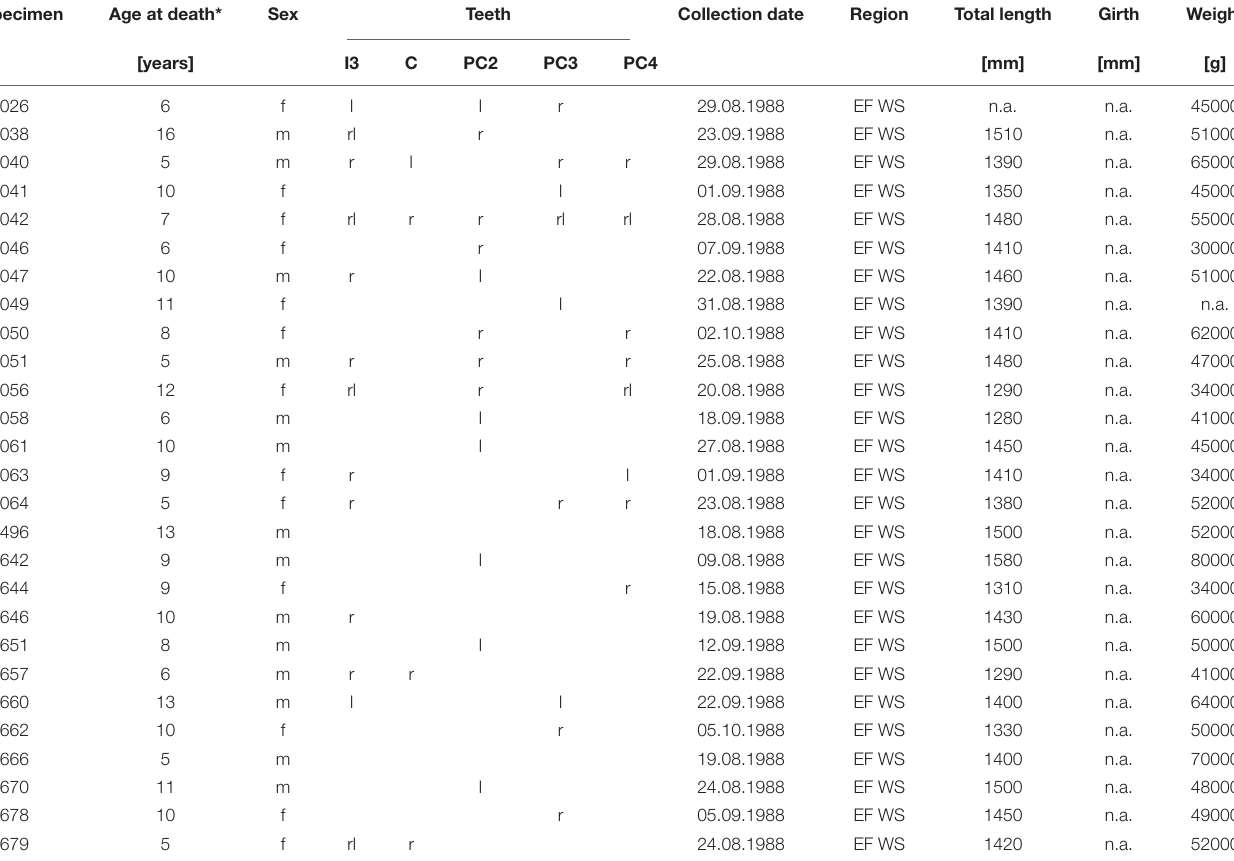
hypotheses ( Table 3 ): sex (females versus males), age (5 years old versus 10 year old), season (summer = June/July versus fall = September/October); in each group sorted according to tooth position (I3/C/PC2/PC3/PC4); and additionally a pooled dataset with all specimens sorted according to tooth position (I3/C/PC2/PC3/PC4). All data were trimmed 15% in